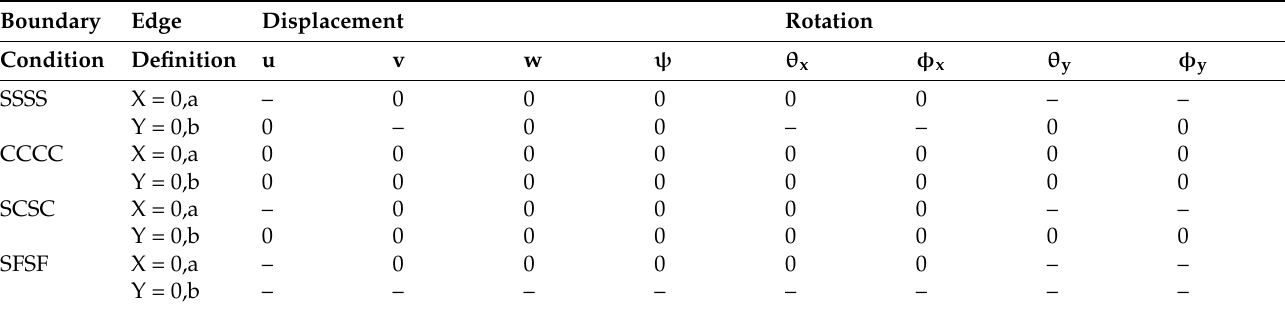
Table 2. Definition of the various boundary condition for the analysis of the